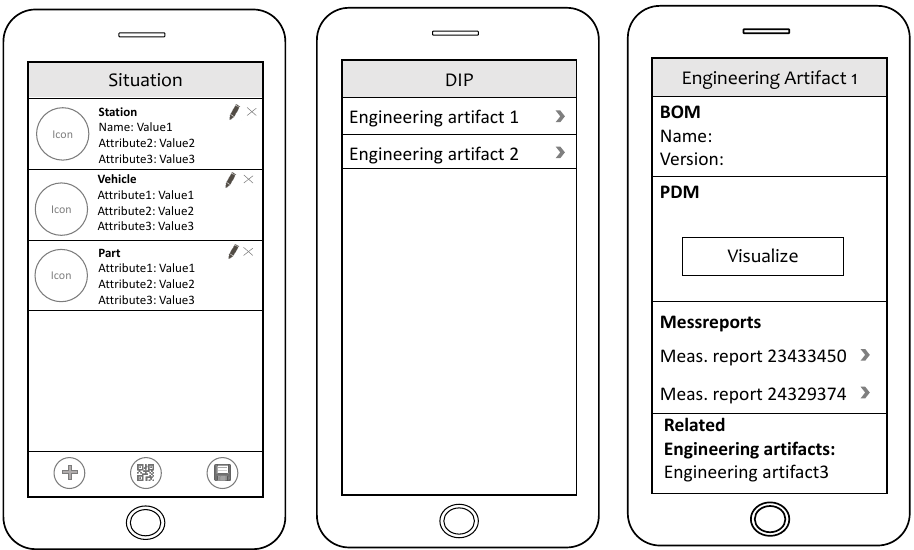
Figure 10. User interface of the DIPPing